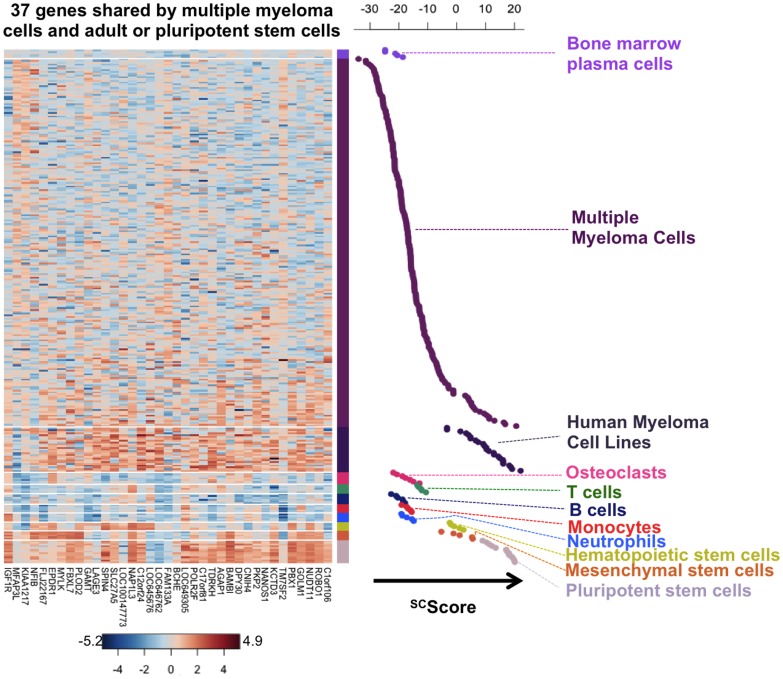
Expression profile of the 37 genes shared by multiple myeloma cells, adult or pluripotent stem cells.A heatmap of the expression of these genes is shown for normal bone marrow plasma cells, primary multiple myeloma cells from patients, myeloma cell lines, 5 populations of differentiated cells (B cells, T cells, neutrophils, monocytes and osteoclasts) and 3 human stem cell populations (pluripotent stem cells, hematopoietic stem cells and mesenchymal stem cells). Each value represents the difference from the gene median across normal and malignant samples and is depicted according to the color scale shown at the bottom (−5.2 to 4.9 on a log base 2 scale).